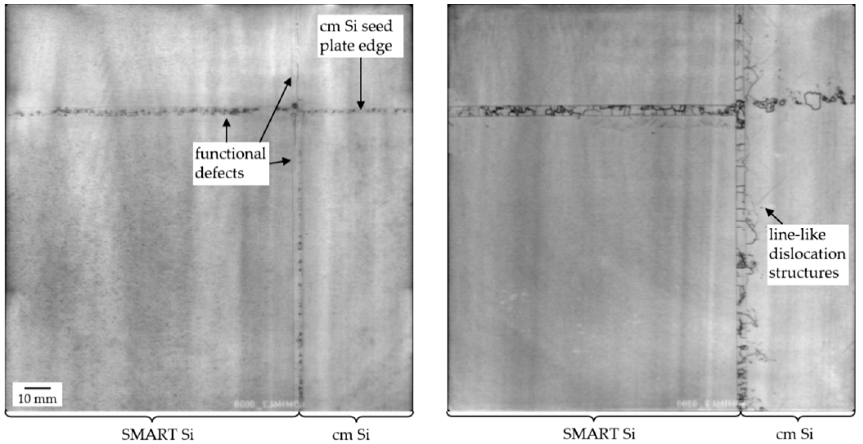
Figure 4. PL image of monocrystalline area surrounded by functional defects on as cut wafers at 28 mm ( left ) and 70 mm ( right ) ingot height. 28 mm ( left ) and 70 mm ( right ) ingot